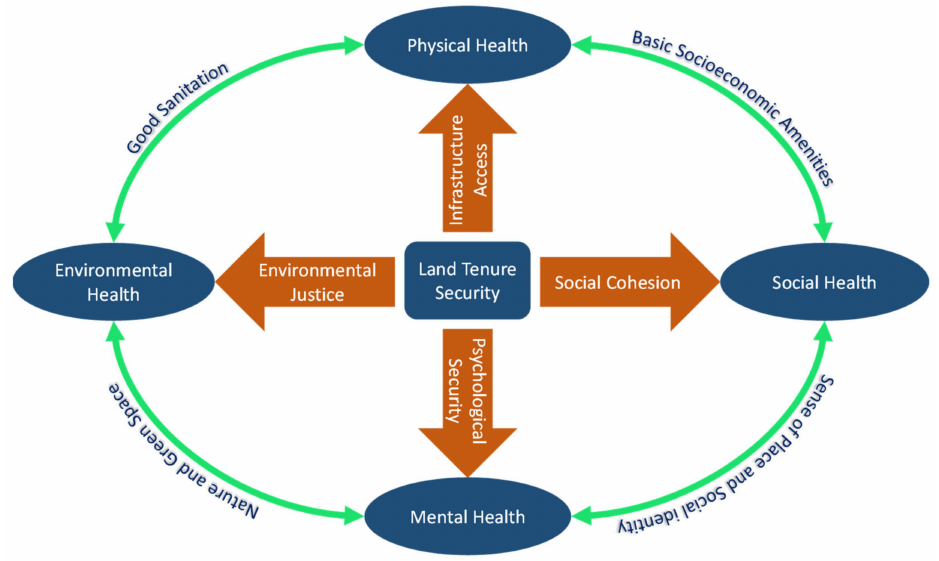
Figure 2. Conceptual framework for land tenure security and health